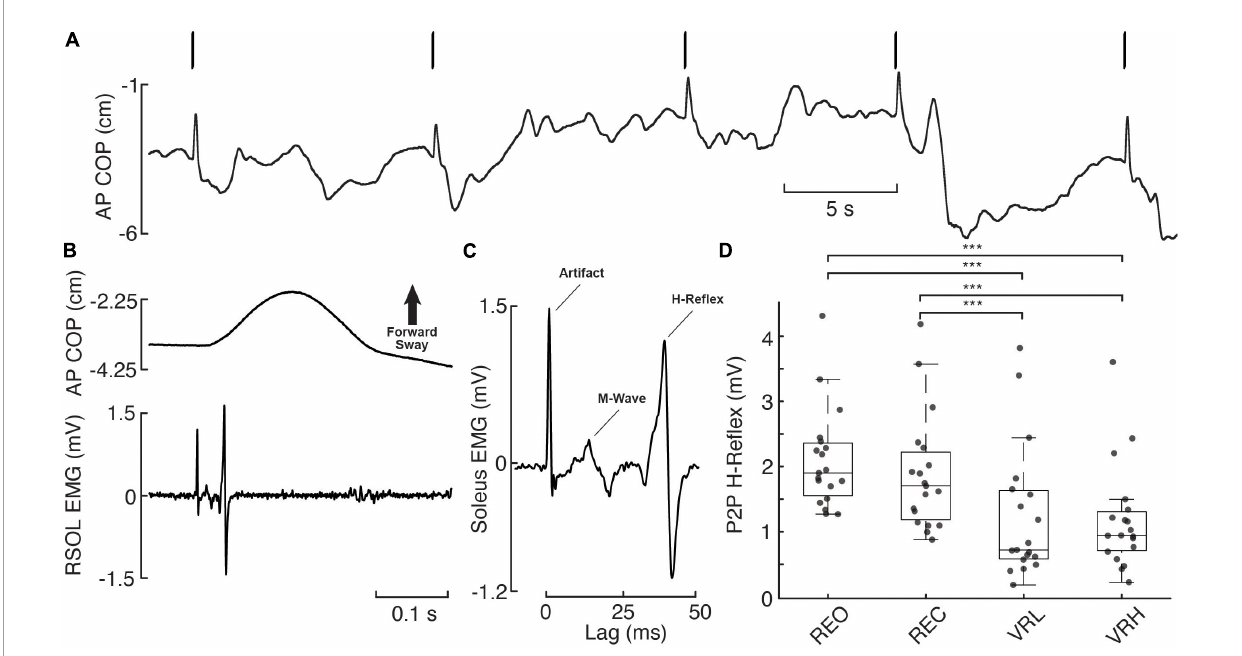
FIGURE4 H-reflex responses across real and virtual visual conditions. (A) Anteroposterior (AP) centre of pressure (COP) during 5 consecutive electrical stimulation pulses (bars overtop), delivered to the tibial nerve at the popliteal fossa (S29, REO). A notable, forward-directed transient in AP COP postural sway resulting from rapid plantar flexion is observed in response to each electrical pulse. (B) Exemplary postural (AP COP) and muscular (RSOL EMG) response to electrical stimulation from a single pulse (initial pulse in panel A ). (C) Stimulus-triggered average of the 5 consecutive pulses from this trial, with the RSOL stimulus artifact, M-Wave, and H-Reflex labeled. (D) Individual participant (gray dashed lines/diamonds) and average (black bars) peak-to-peak (P2P) H-reflex amplitudes. Asterisks denote significance at the p < 0.001***